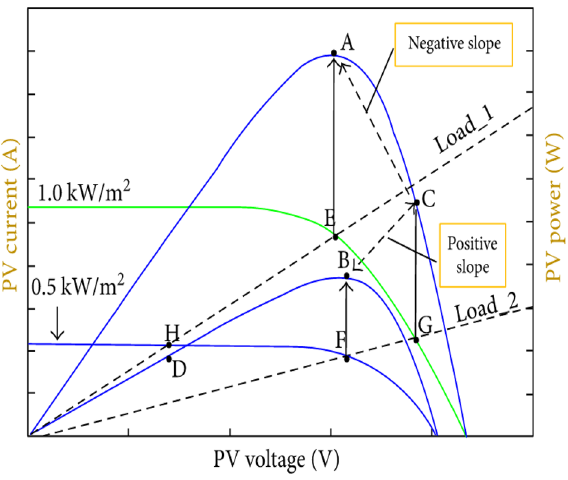
Figure 6. The P–V and I-V curves under radiation 1000 W/m 2 and 500 W/m 2 .